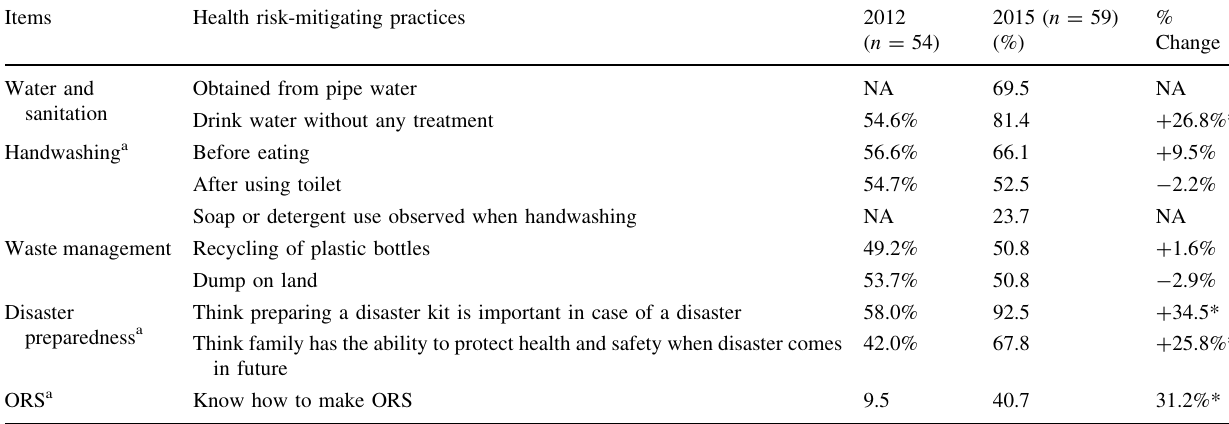
Table 5 Comparison of various self-reported health-related beliefs and practices in Hongyan village